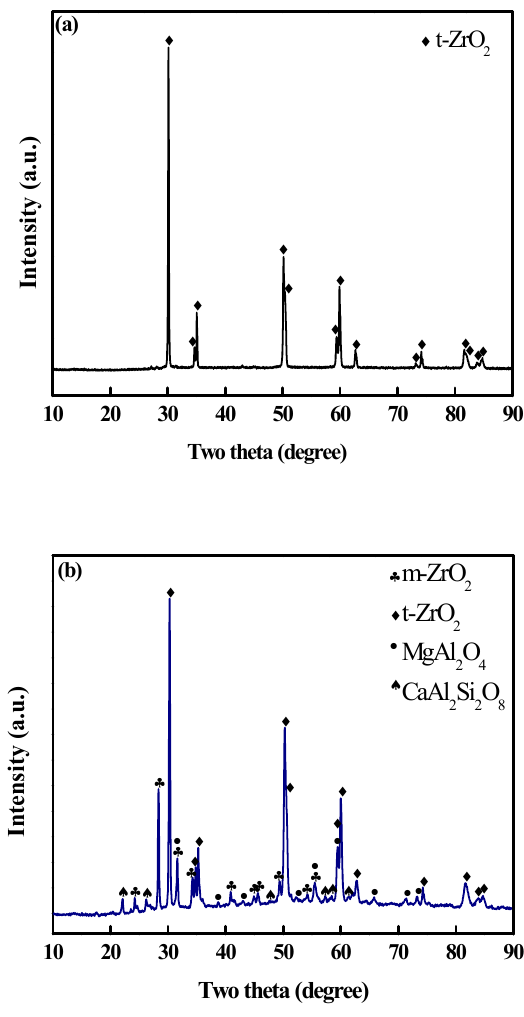
Figure 4. XRD patterns of the TBC surface: ( a ) as-sprayed specimen; ( b ) specimen after failure.